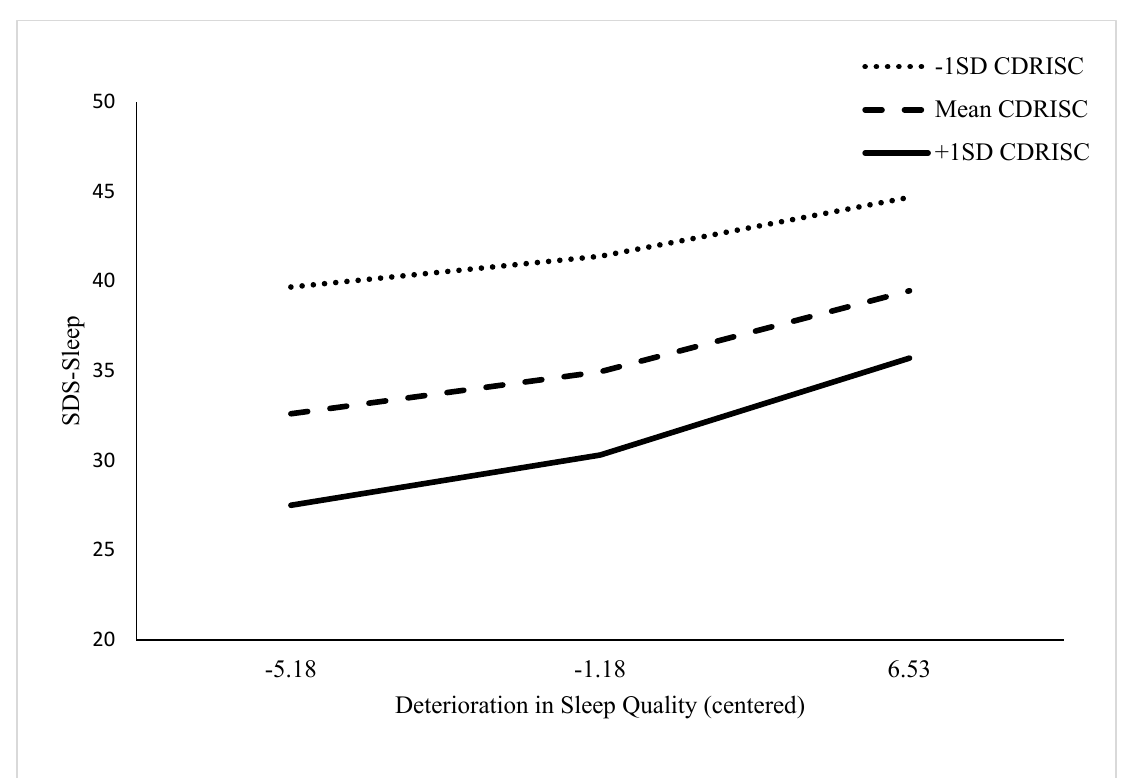
Figure 1. Interaction plot for SIS, CDRISC, and SDS-Sleep scores for 55 patients with PCa.